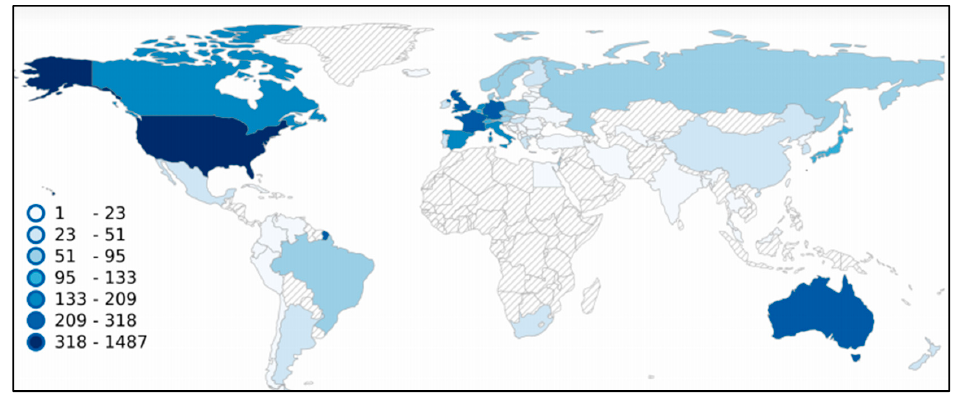
Figure 5. Locations of melanoma clinical trials by country. The map was generated based on data from the ICTRP [1]. Our search was performed on 30 November 2018 using the term “melanoma”. All results with location data are presented as a heatmap.